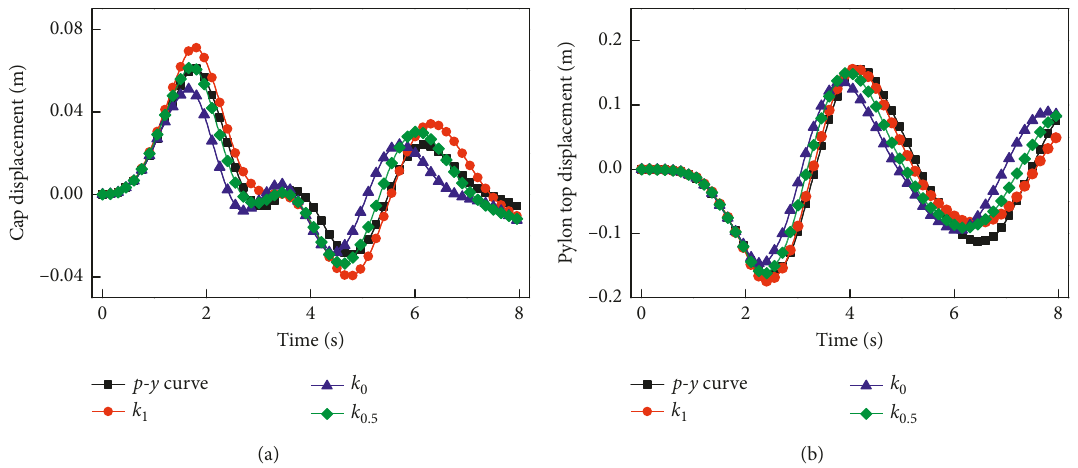
Figure 17: Bridge pylon lateral displacements using different SPI models. (a) Cap lateral displacement. (b) Pylon top lateral displacement.